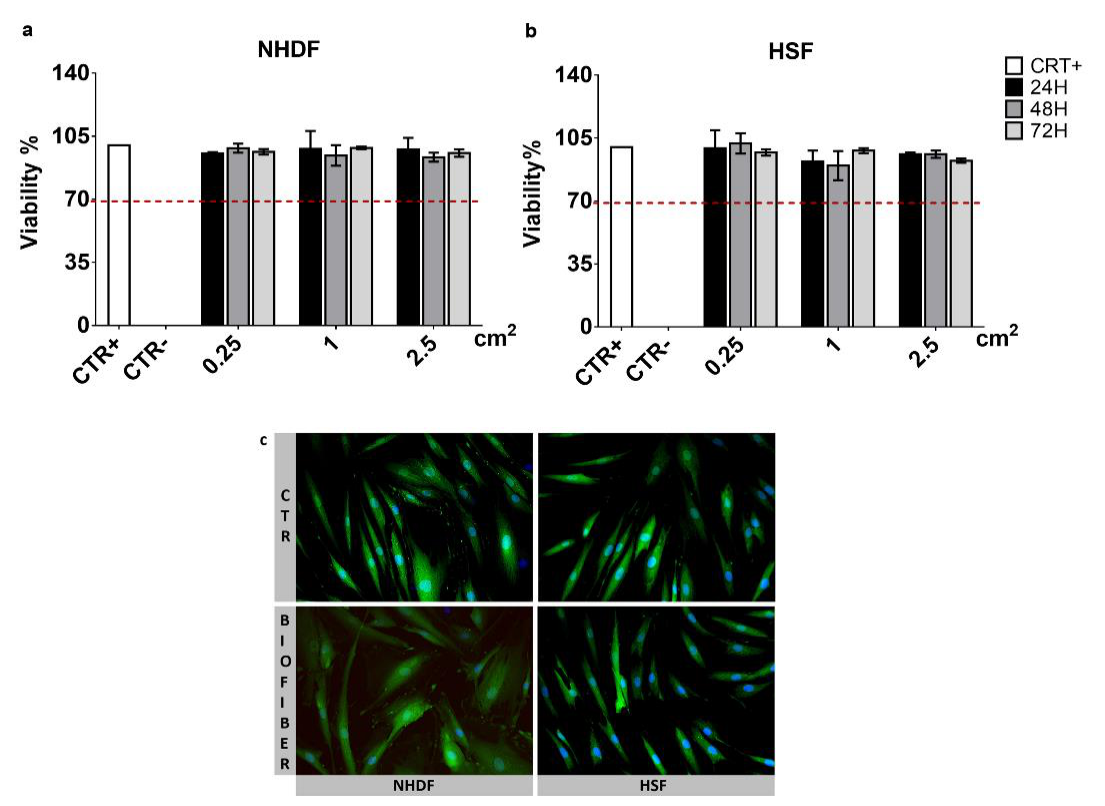
Figure 10. Indirect MTT cytotoxicity assay on NHDF ( a ), and HSF ( b ); Biofiber extracts (0.25, 1, 2.25 cm 2 ) in DMEM (2 mL) at 37 °C for 24 – 72 h were used as the treatment solution. Untreated cells have been used as positive (CTR+) while, treated with phenol as negative control (CTR − ). The viability